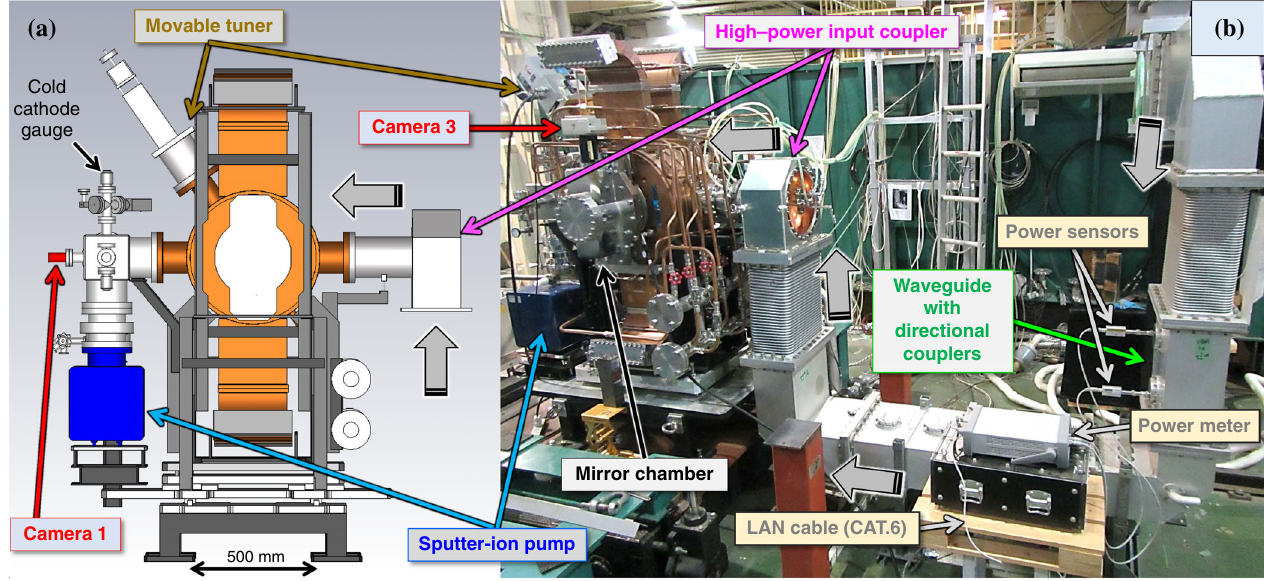
FIG. 3. (a) Diagram of DR cavity No. 0. (b) Photograph of the test stand used for the high-power test of DR cavity No. 0 in a radiation- controlled area. The bold arrows indicate the flow of high rf power generated by a 1.2-MW continuous-wave klystron. The klystron is not included in this photograph. The turbo-molecular pump is behind the sputter-ion pump. The cavity was cooled by water with a temperature of 30 °C and a total flow rate of 140 L/min. No beam was injected into any cavity in this test stand.